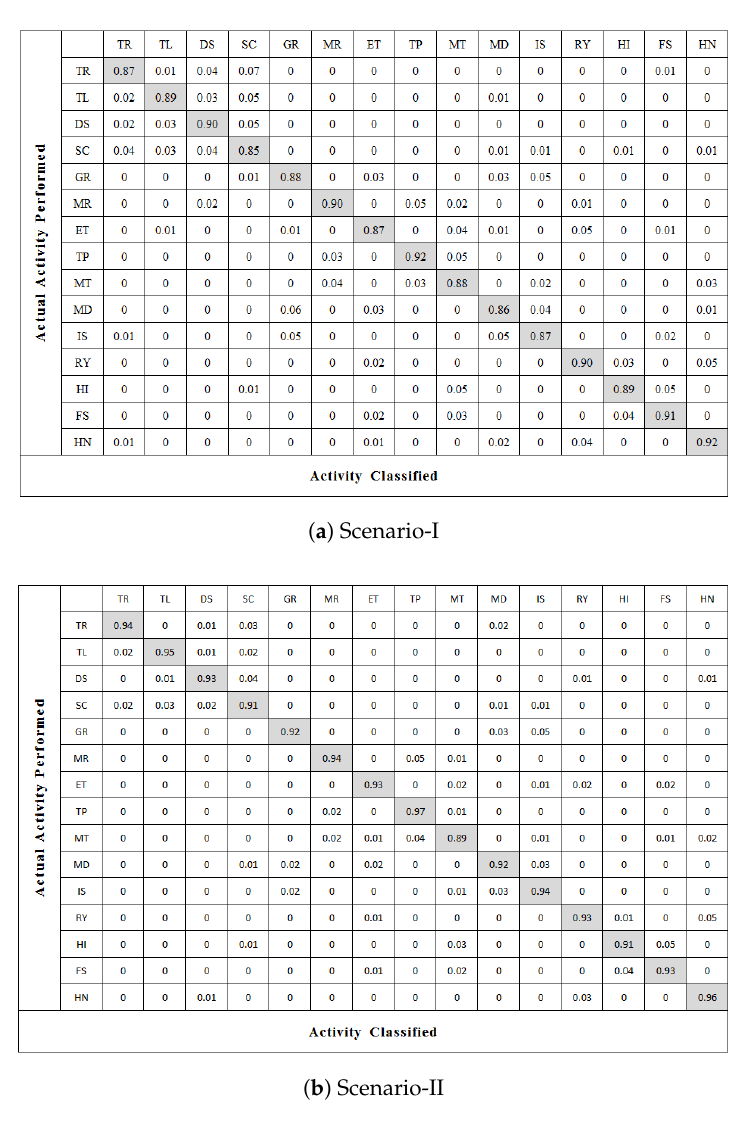
Figure 9. Confusion matrix of activity recognition using GC-S